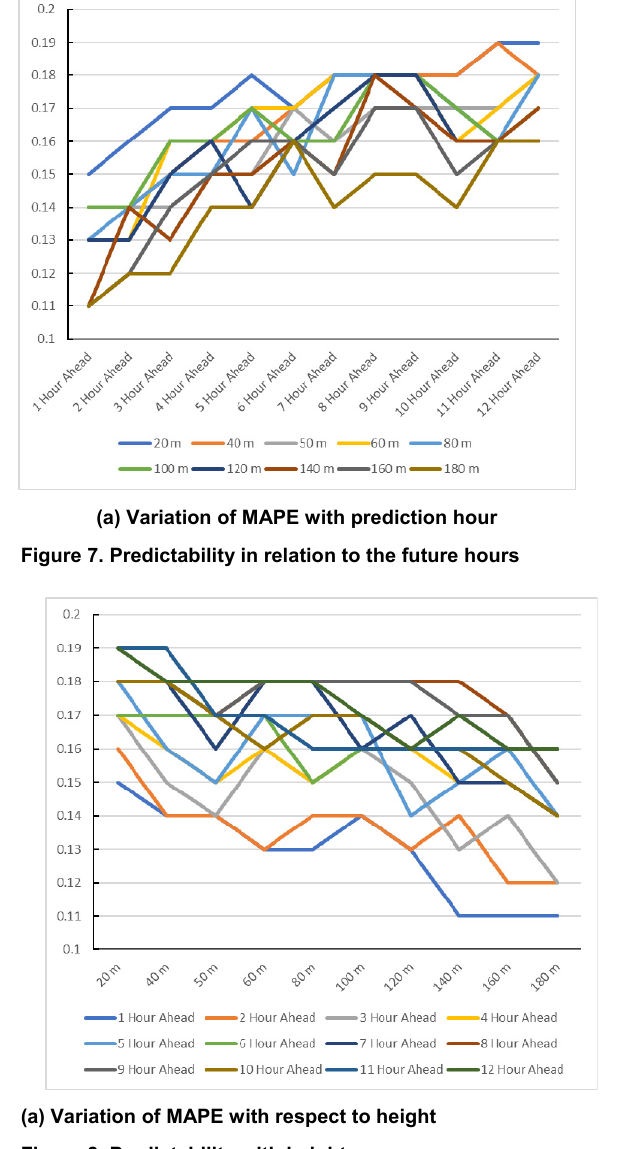
Figure 8. Predictability with